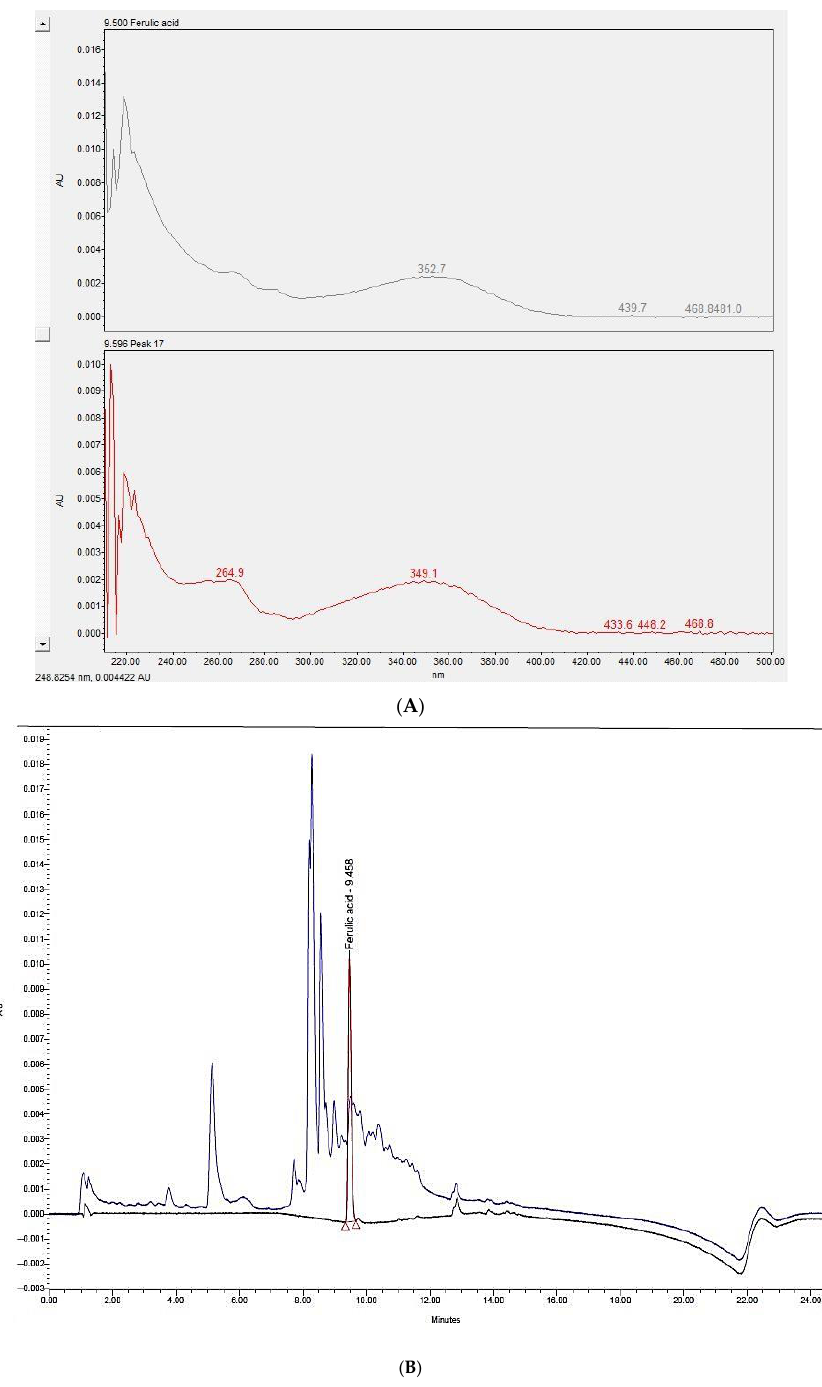
Figure 1. UPLC analysis of Phoenix dactylifera L. seed extract. ( A ) The absorbance at 330 nm of P. dactylifera L. seed extract (blue peak) and ferulic acid (black peak). ( B ) Scan spectra between 220 and 500 nm of P. dactylifera L. seed extract and ferulic